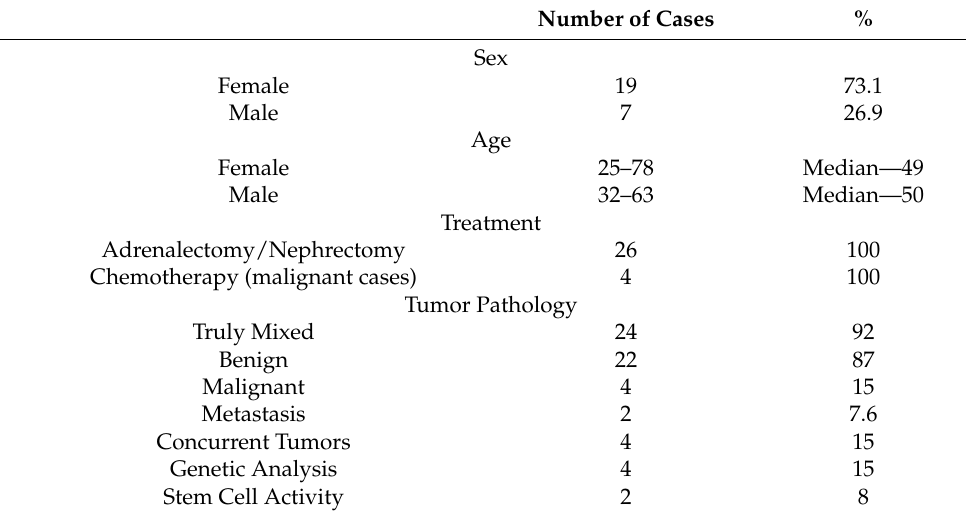
Table 1. Characteristics of